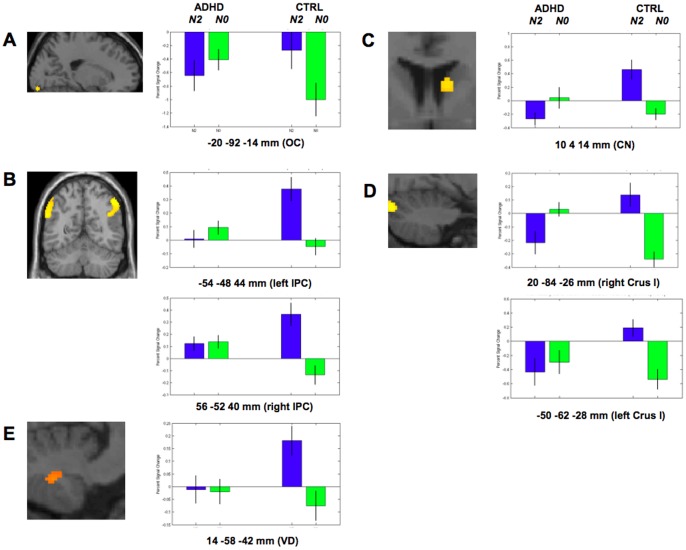
Percent BOLD signal changes from baseline levels in N2 and N0 conditions in Control and ADHD children.OC: occipital cortex; IPC: inferior parietal cortex; VD: ventral dentate (cerebellum); CN: caudate nucleus; Crus I (cerebellum). Activated areas are displayed at punc <0.001, superimposed on the ICBM standardized anatomical template.